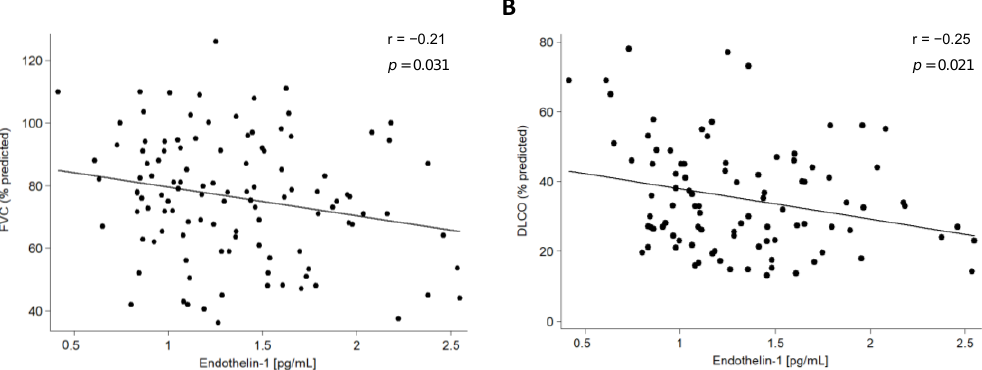
Table 1. Association between ET-1 serum levels and clinical characteristics of the patients included in the study.